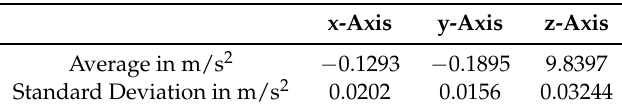
Table 8. Acceleration measurements.